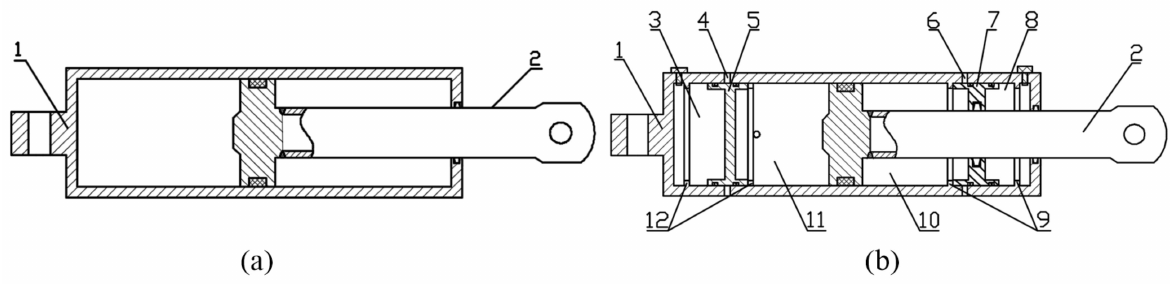
Figure 2. Structure comparison of the balance jack: ( a ) the traditional balance jack; ( b ) the multi- adaptive response balance jack. 1. cylinder body; 2. piston rod; 3. rodless cavity buffer cavity; 4. rodless cavity unloading hole; 5. rodless cavity floating piston; 6. Rod cavity unloading hole; 7. rod cavity floating piston; 8. rod cavity buffer cavity; 9. 12 limit boss; 10. 11 oil